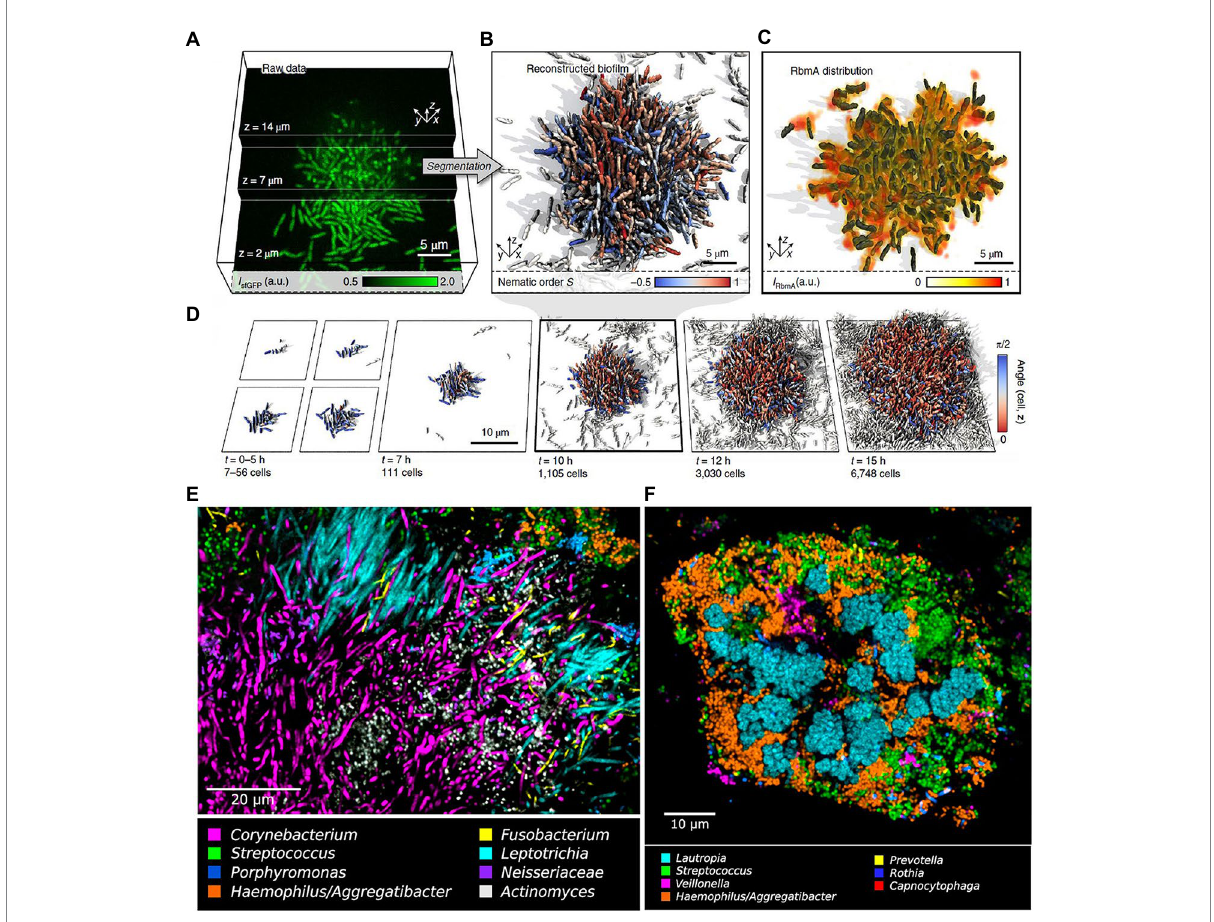
FIGURE 1 Biofilm growth and structure . (A) Confocal microscopy images of Vibrio cholerae cells constitutively expressing a green fluorescent protein at three different z planes. (B) 3D reconstruction of the biofilm shown in (A) , cells are colored according to the nematic order parameter S = <3_2 (n_